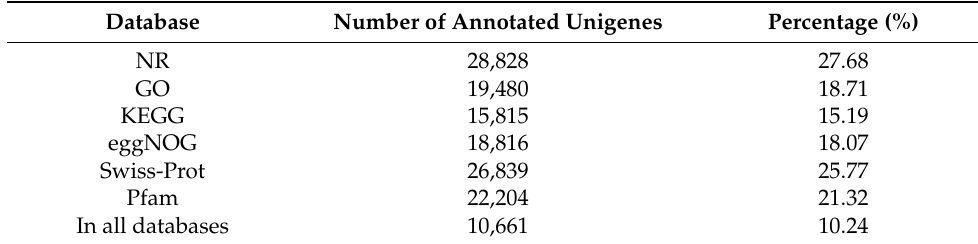
Table 2. Gene function annotation.